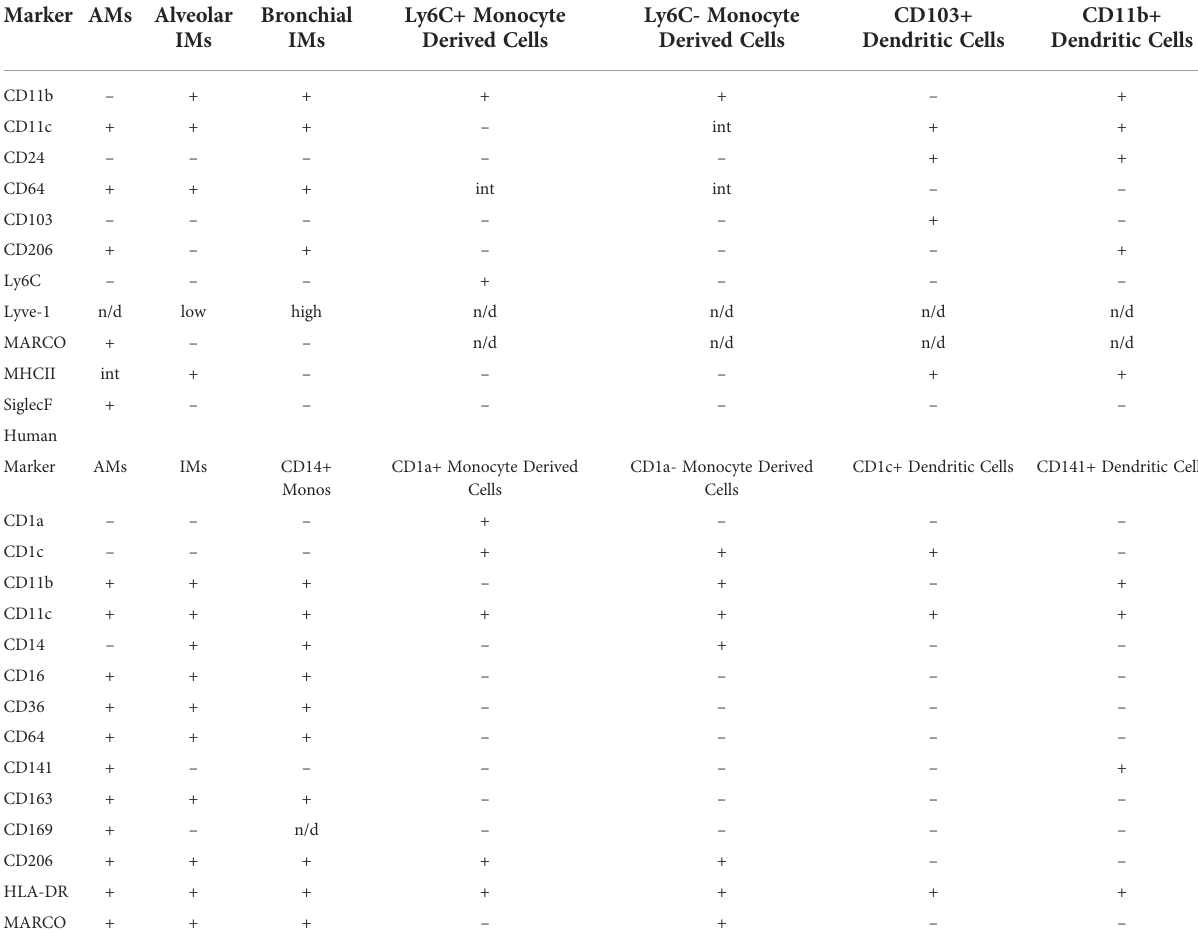
TABLE 3 De fi ning markers of pulmonary mononuclear phagocyte subsets in mice and humans at steady state (118 – 121). Mice Marker AMs